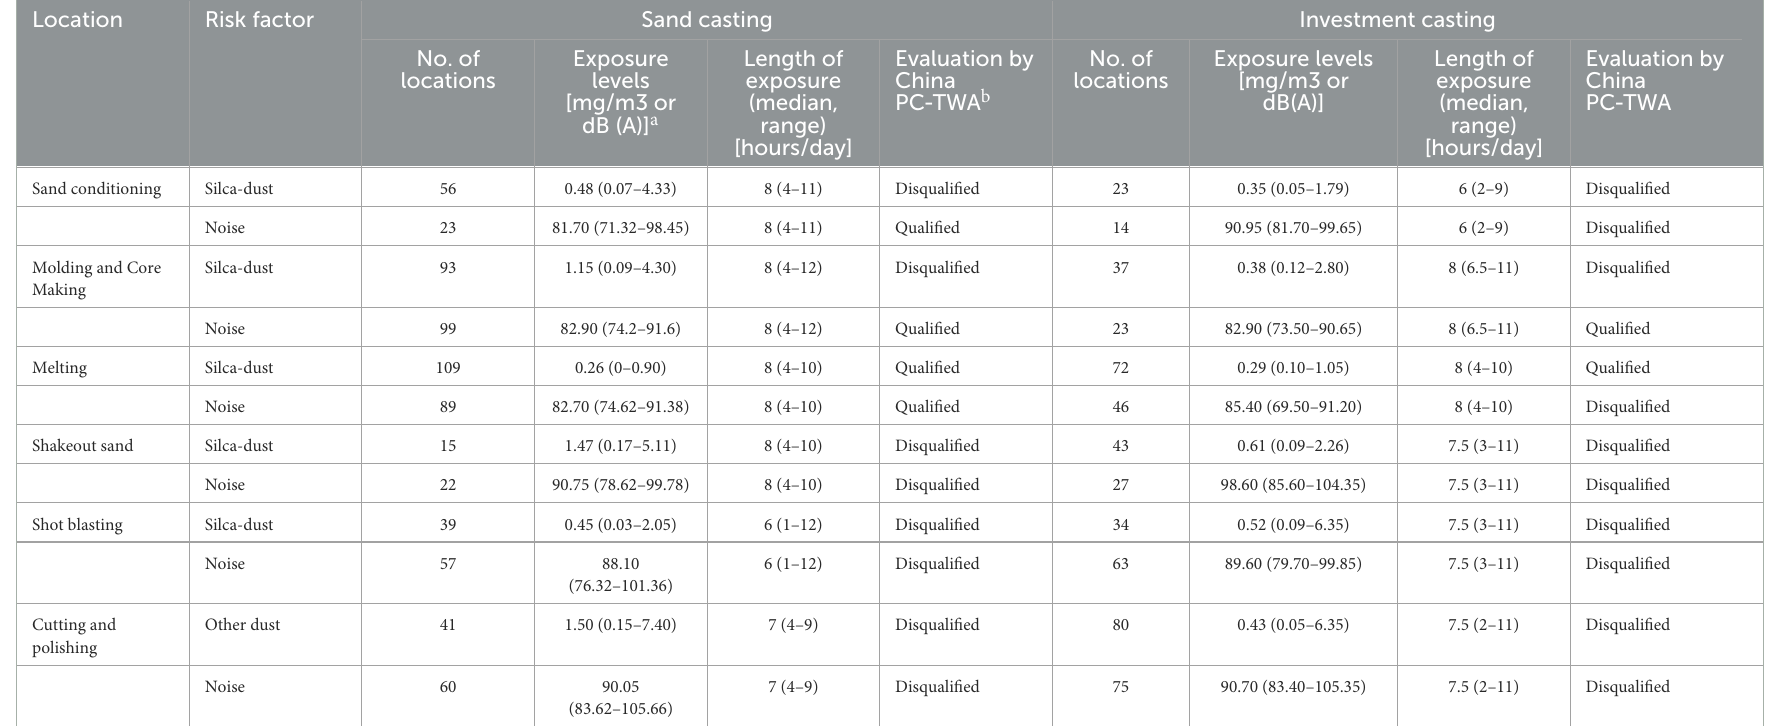
TABLE 3 Identification of main occupational hazards in ferrous casting